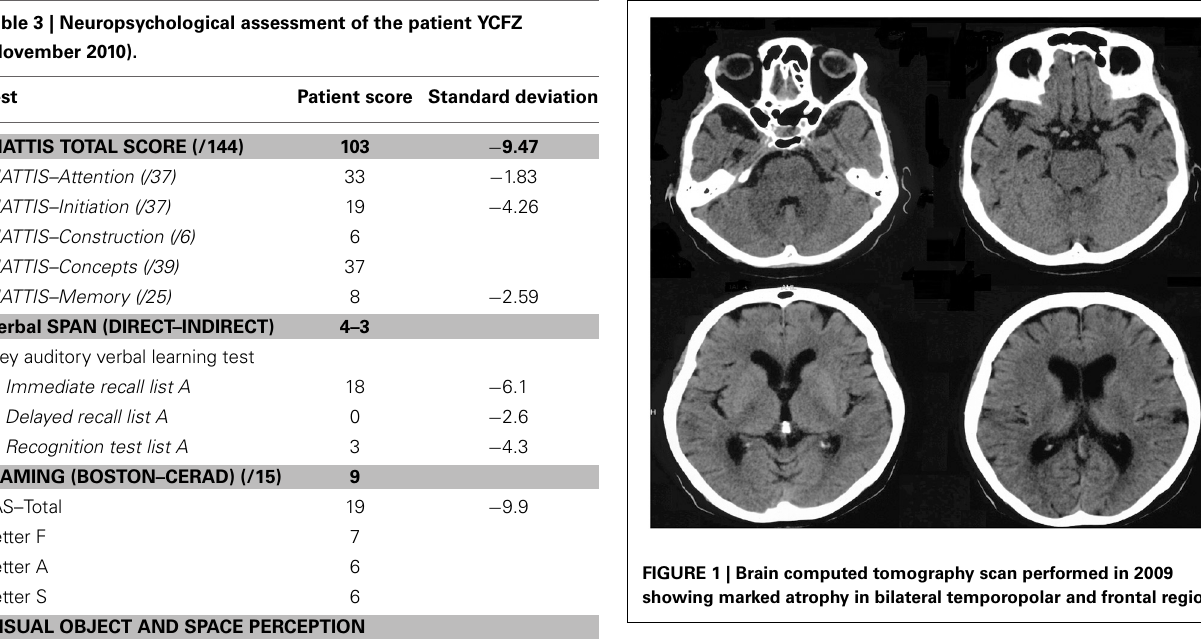
original or new is the painting? “Representation”: How well is the subject of the painting rendered? “Technique”: How much